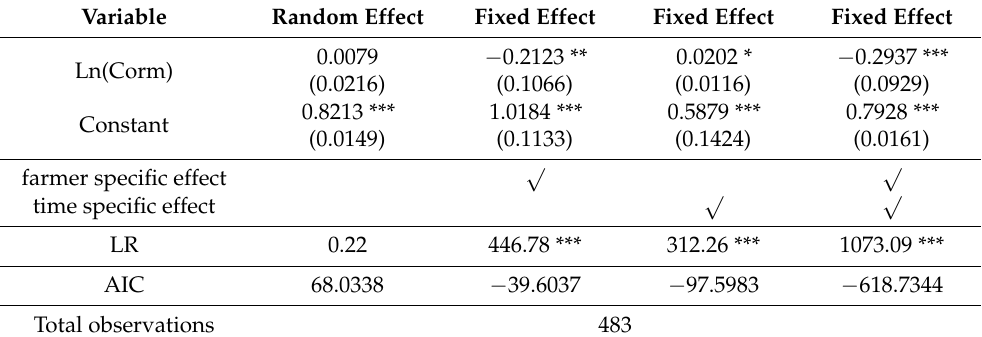
Table 8. Panel BTR estimation results of the effect of corm planting density on technical